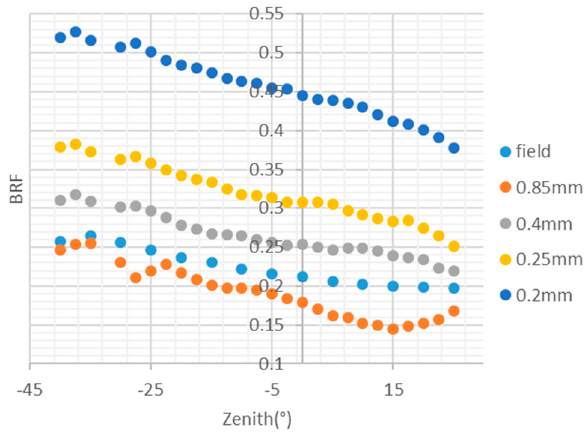
Figure 11. Photo of the physically simulated scene.